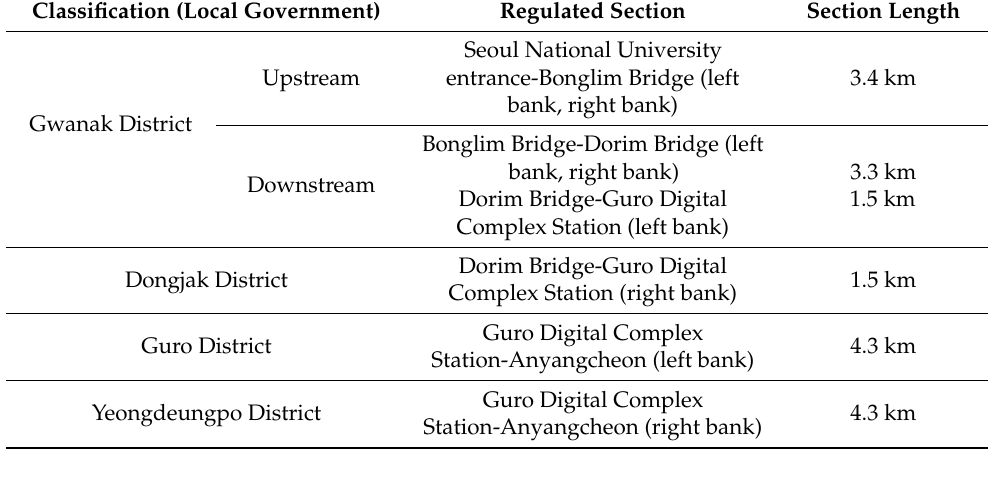
Table 3. Blocked section of Dorim river in a warning rainfall event.